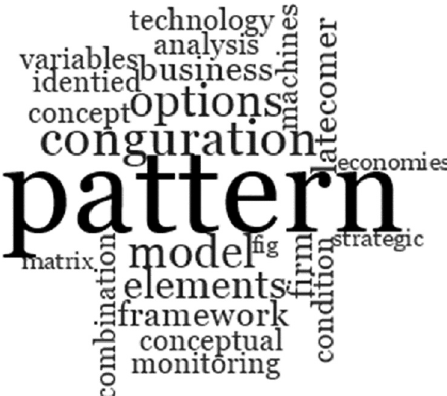
Figure 11. The 10th